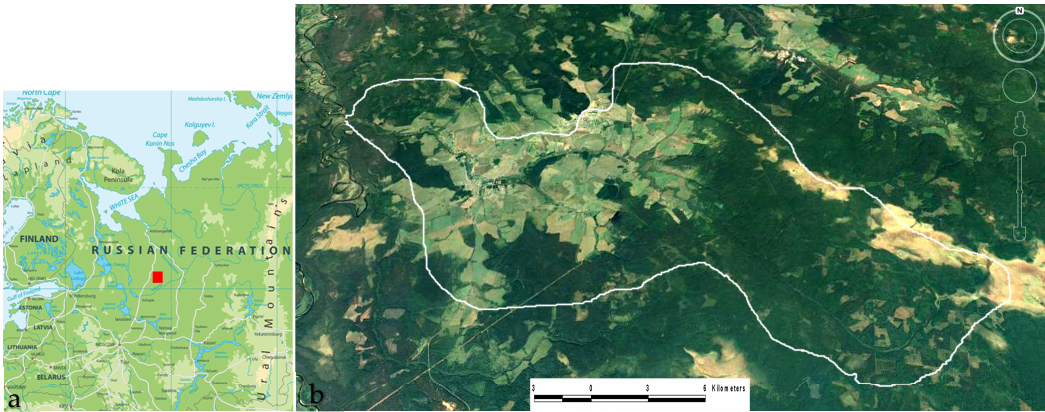
Figure 2. Study area: ( a ) Location of the study area in the East-European Plan, Arkhangelsk region (red rectangle); ( b ) The Zayachya river basin. Source: Google Earth, 2020 CNES/Airbus.